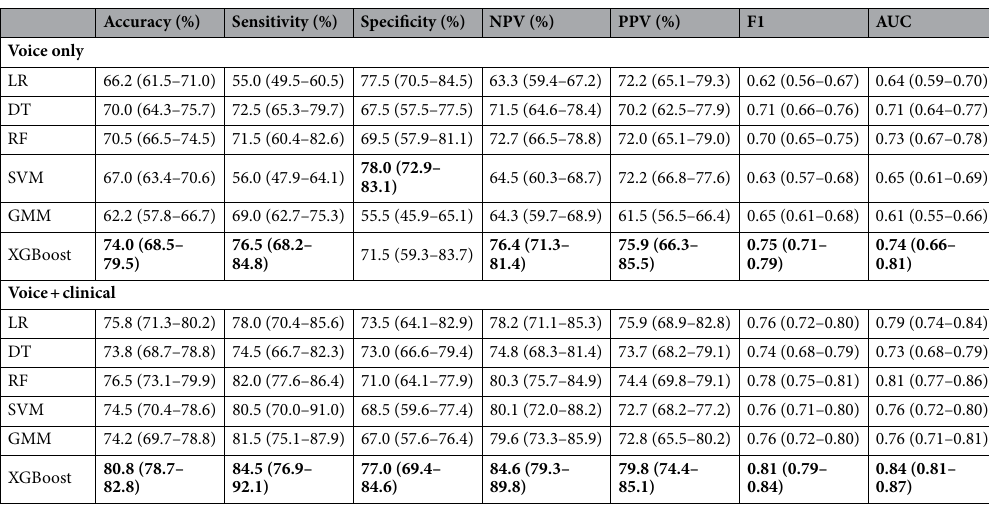
Table 4. Evaluation metric table of samples for voice signals in classifying risk of respiratory complications. Values are presented in mean (95% confidence interval). Values with bold-text represent the highest values among the models. NPV negative predictive value, PPV positive predictive value, AUC area under curve, LR logistic regression, DT decision tree, RF random forest, SVM support vector machine, GMM Gaussian mixture model, XGBoost extreme gradient